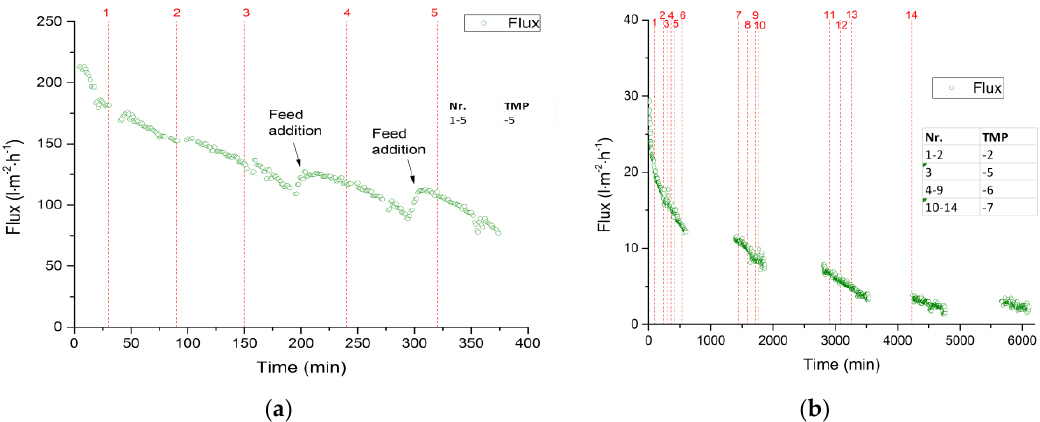
Figure 7. Membrane filtration performance during the filtration of spent sulfite liquor (feed temperature = 60 °C, CFV = 6 m∙s −1 , Re = 12,876, τ w = 140 Pa, TMP = 3 bar). ( a ) 30-nm ceramic hollow fiber membrane. ( b ) 3-nm ceramic hollow fiber membrane (data gaps show where the filtration process was interrupted overnight).